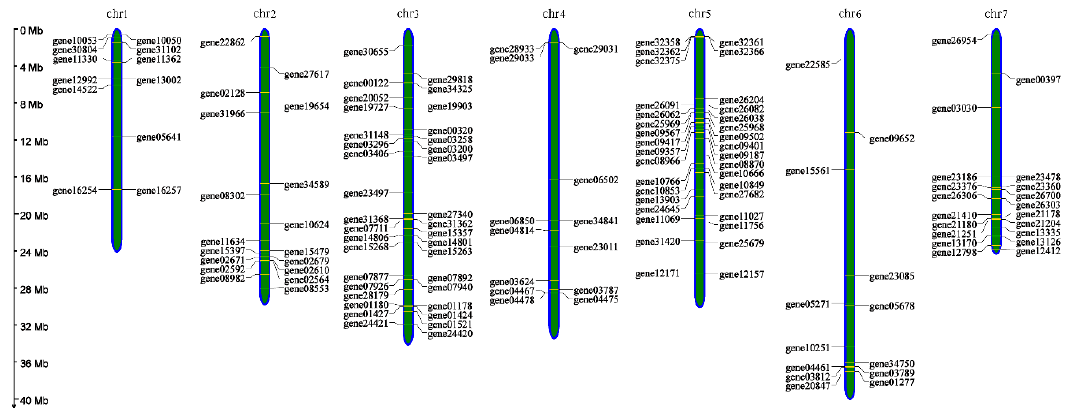
Figure 7. Constructed physical maps of Fragaria using 146 predicted genes related to self-incompatibility. The IDs for the genes are shown on the chromosome and the chromosomal locations of genes are indicated by the axis of ordinates on the right.